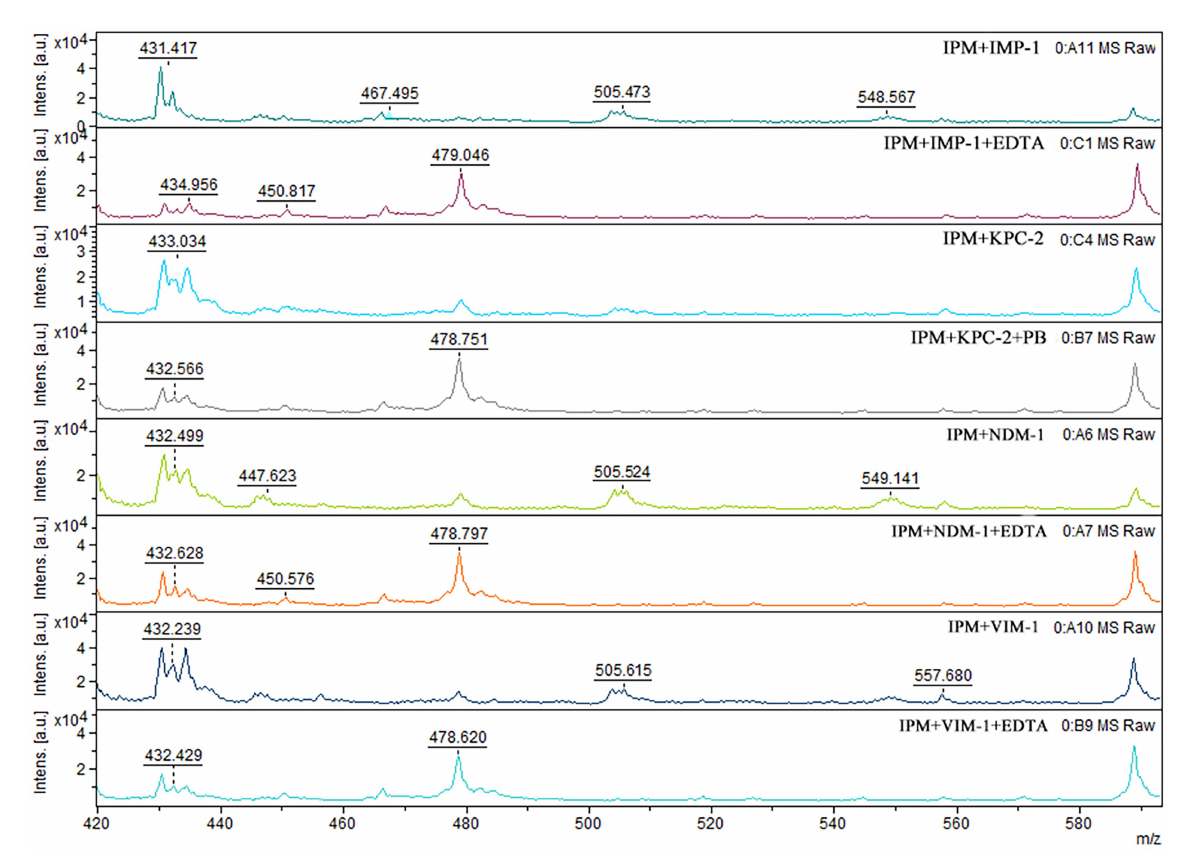
FIGURE 2 Mass spectra of the IPM hydrolysis assay with CPE. After CPE hydrolysis, the MS peak near 479 m/z disappeared. Upon addition of EDTA or PB, the MS peak near 479 m/z